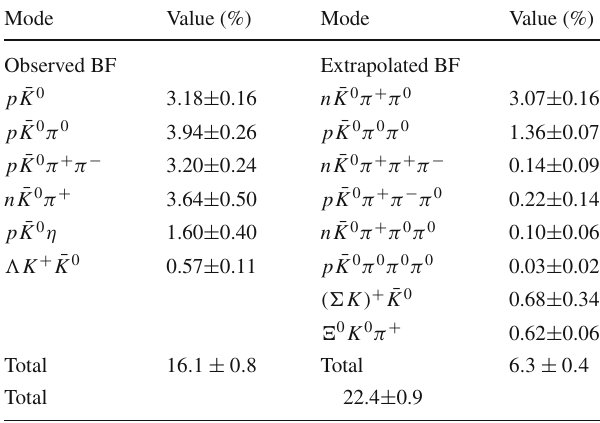
Table 1 Observed and extrapolated BFs for exclusive ¯ K 0 / K 0 decays of (cid:2) + c CF decays [2,11]. Here, observed BFs are referred from Particle DataGroup(PDG)[2]andextrapolatedBFsarereferredfromRef.[11]. BFs of the ¯ K 0 / K 0 decay modes are obtained by doubling those